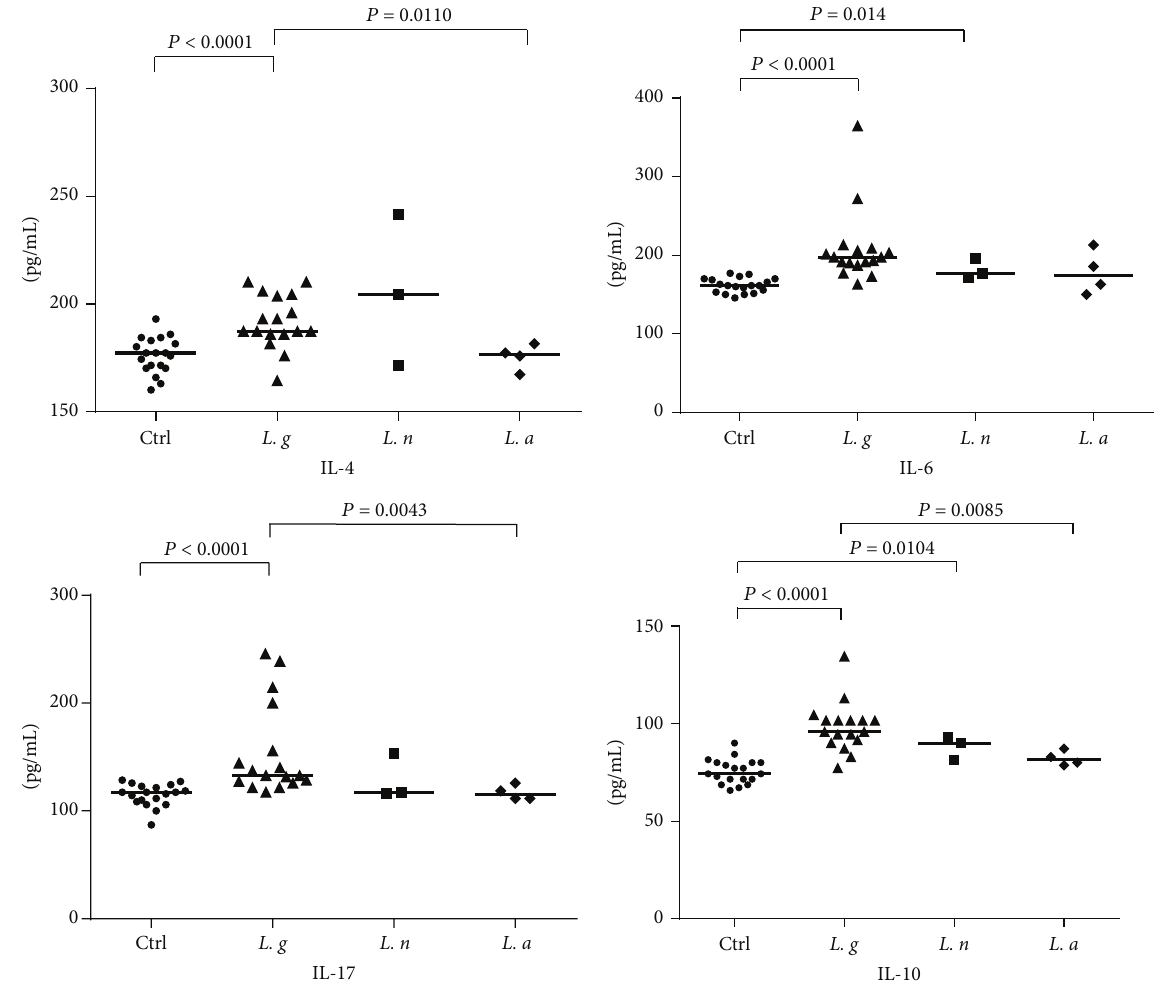
Figure 2: Levels of IL-4, IL-6, IL-10, and IL-17 in serum samples from patients infected with different Leishmania species and in noninfected control. Cytokine levels (pg/mL) were calculated for each serum sample. Means (horizontal lines) are shown for each group. Ctrl: noninfected control; L. g : L . guyanensis ; L. n : L . naiffi ; L. a : L.amazonensis